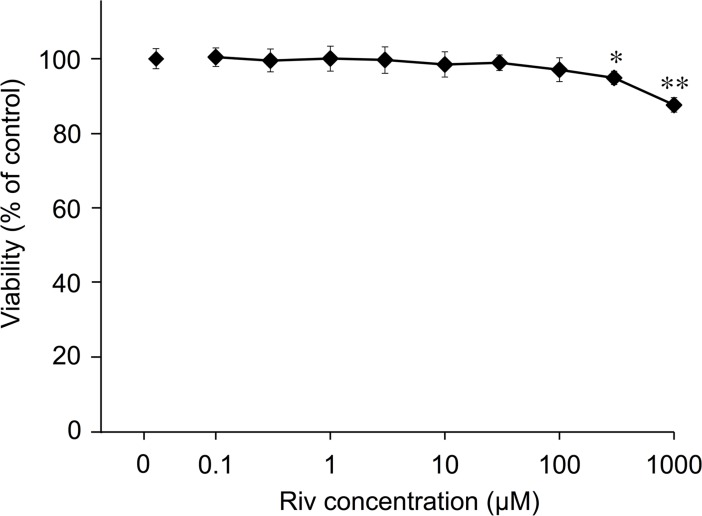
Influence of Riv on PC12 cell viability.PC12 cells were treated with Riv for 24 h. Cell viability was determined using a WST-1 assay, and the results are expressed as a percentage of the control value (0 μM). Experiments were repeated at least three times, and the values represent the mean of three experiments ± SD. *p < 0.05, **p < 0.01 versus control.